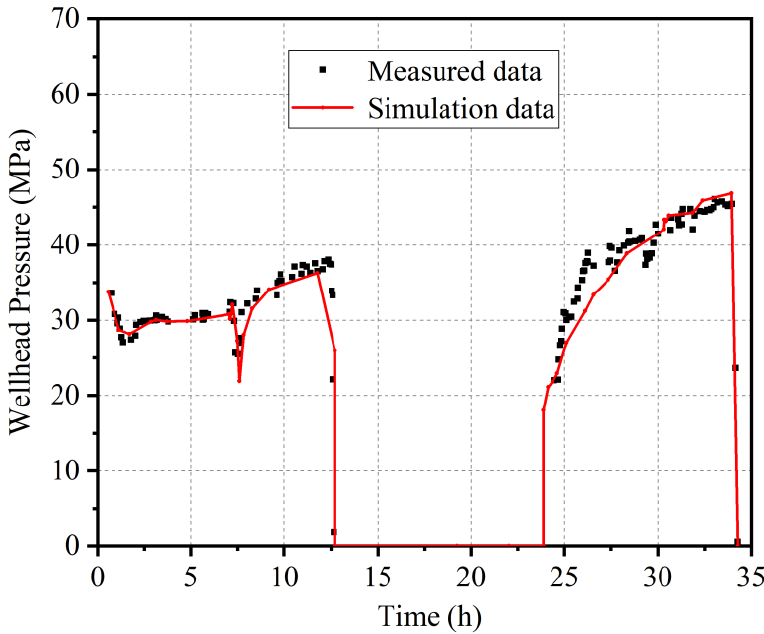
Figure 6. Comparison of measured and simulated results of reservoir stimulation in the first stage. In the second stage, the water injection rate is 4.0–5.5 m 3 /min, which lasts for 3 days.